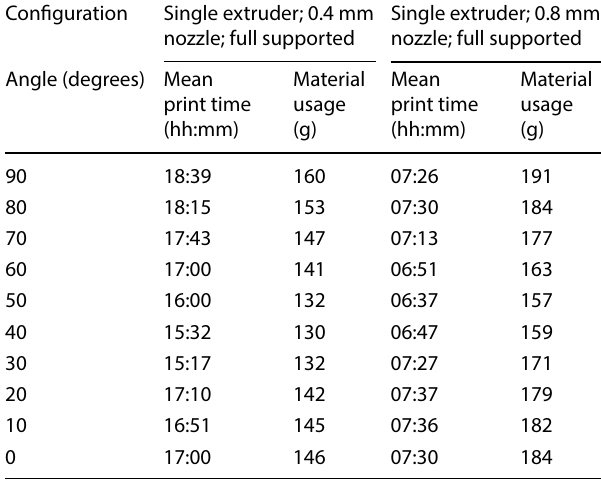
Table 3 Slicing orientation simulations for one shell